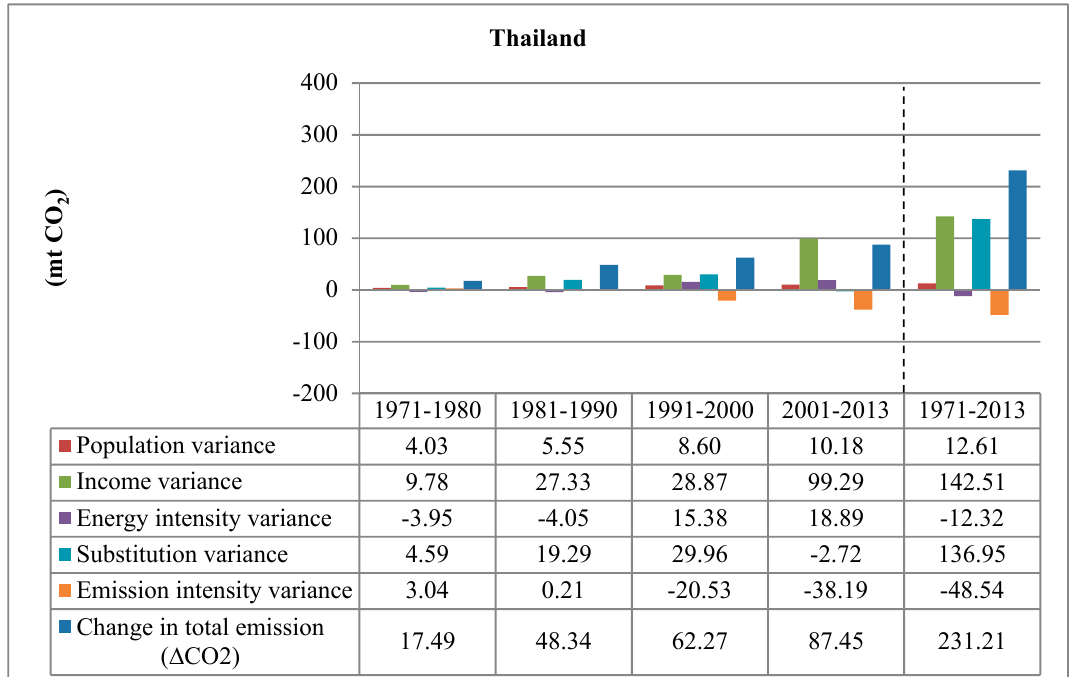
Figure 13. Decomposition results of CO 2 emissions in Thailand